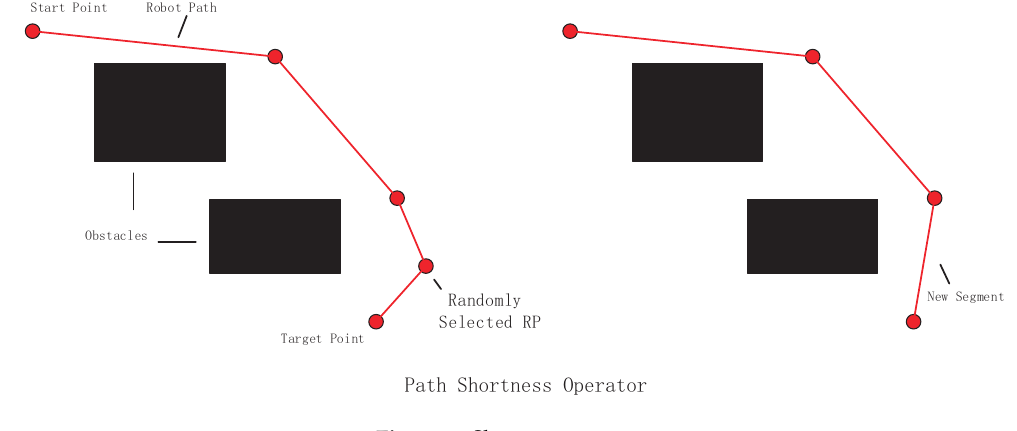
Figure 6. Shortness